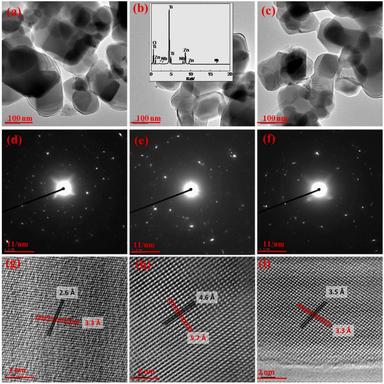
(a–c) TEM images, (d–f) SAED pattern and (g–i) HRTEM images are presented for LZTNO, x ¼ 0 (a,d,g), 0.05 (b,e,h), 0.1 (c,f,i). Measured lattice distances are indicated at the HRTEM images.